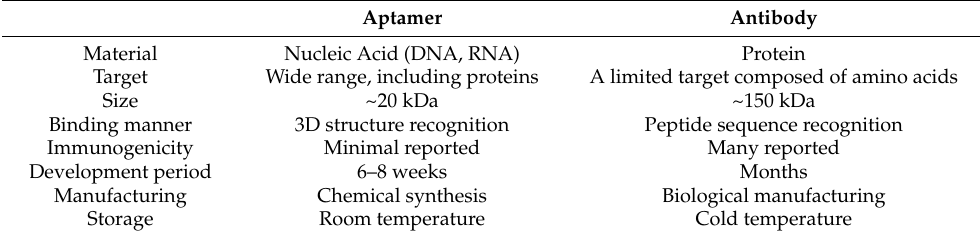
Table 1. Comparison between aptamers and